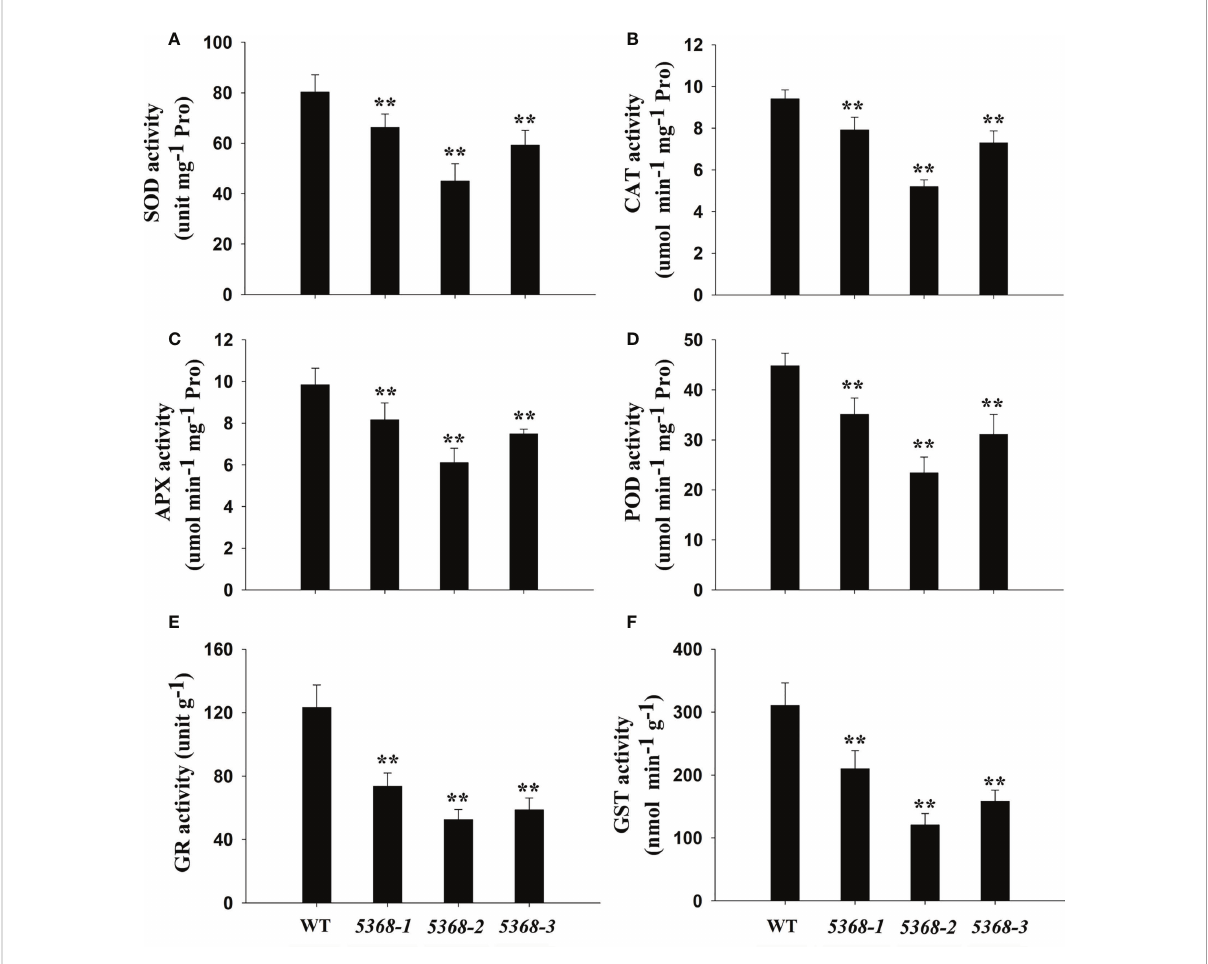
FIGURE 7 Changes in antioxidant enzyme activity in fl ag leaves between WT and LMM 5386 lines. (A) Superoxide dismutase (SOD), (B) catalase (CAT), (C) ascorbate peroxidase (APX), (D) peroxidase (POD), (E) glutathione reductase (GR), and (F) glutathione-S-transferases (GST) activity. Values are means ± SD of three replicates. Error bars indicate standard deviations. **P <